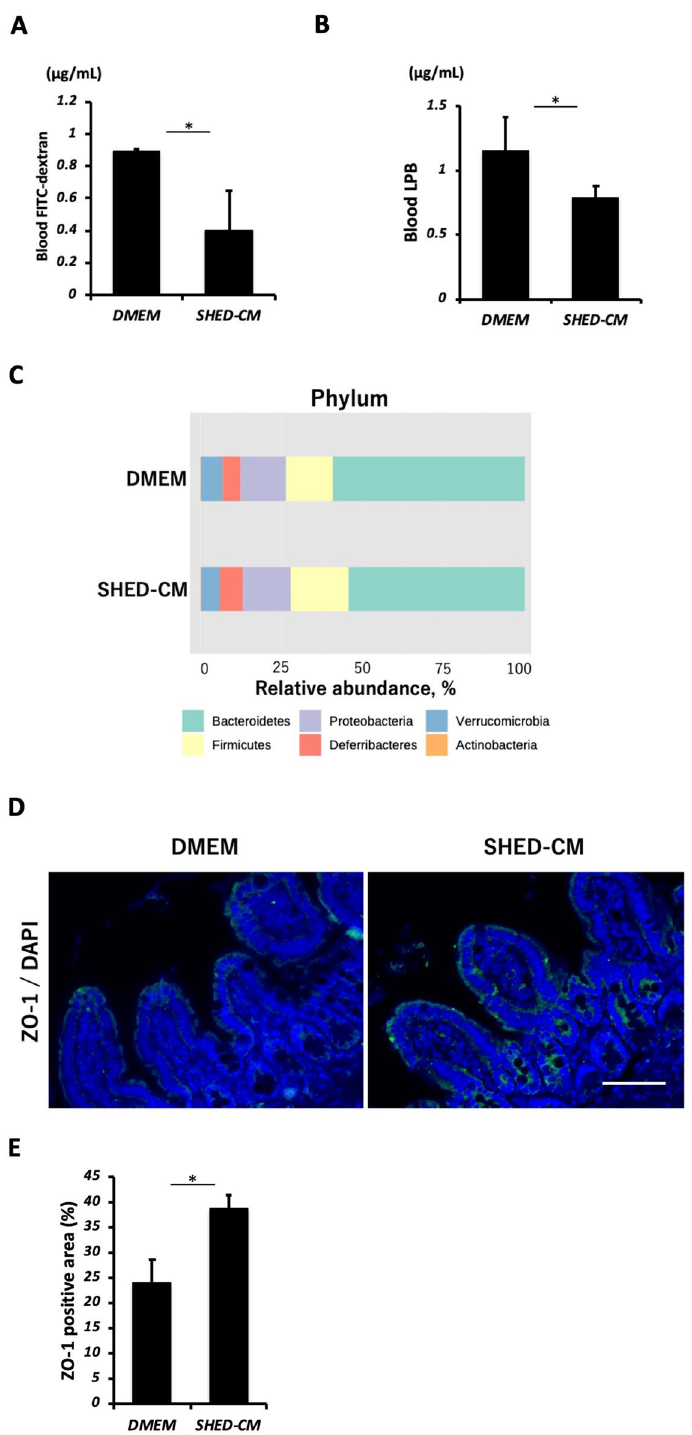
Figure 6. SHED-CM protects the intestinal barrier. ( A ) Concentration of blood FITC-dextran following oral administration to mice. Data represent mean ± SEM. * P < .05. n = 6, DMEM group; n = 8 SHED-CM group. ( B ) Blood LBP concentration. Data represent mean ± SEM. * P < .05. n = 6, DMEM group; n = 8, SHED-CM group. ( C ) Relative abundances of microbiota from cecal contents at the phylum level. n = 6, DMEM group; n = 8 SHED-CM group. ( D ) Representative immunohistological ZO-1 staining images of ileum. Scale bar = 200 μm. ( E ) Quantification of the ZO-1 positive area. Data represent mean ± SEM. * P < .05. n = 3 per group. Abbreviations: FITC, fluorescein isothiocyanate; LBP, lipopolysaccharide-binding protein; DMEM, Dulbecco’s modified Eagle’s medium; SHED-CM, serum-free conditioned medium from stem cells derived from